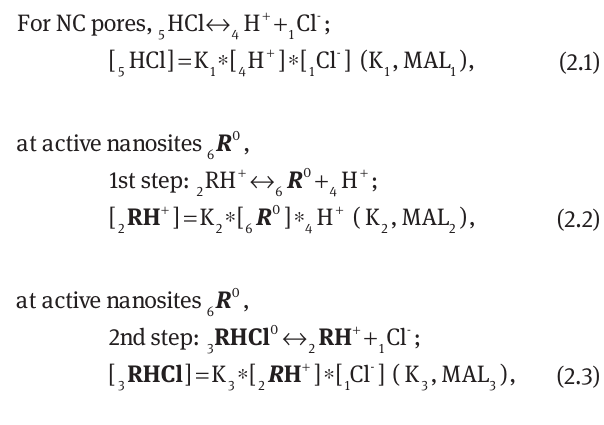
The NC system (2.1–2.3) is characterized by n = 6 compo- nents, three diffusion coefficients (D three MAL reactions: one in the NC pores (2.1) with addi- S tional two association-dissociation MAL (2.3) at the active R 0 nanosites